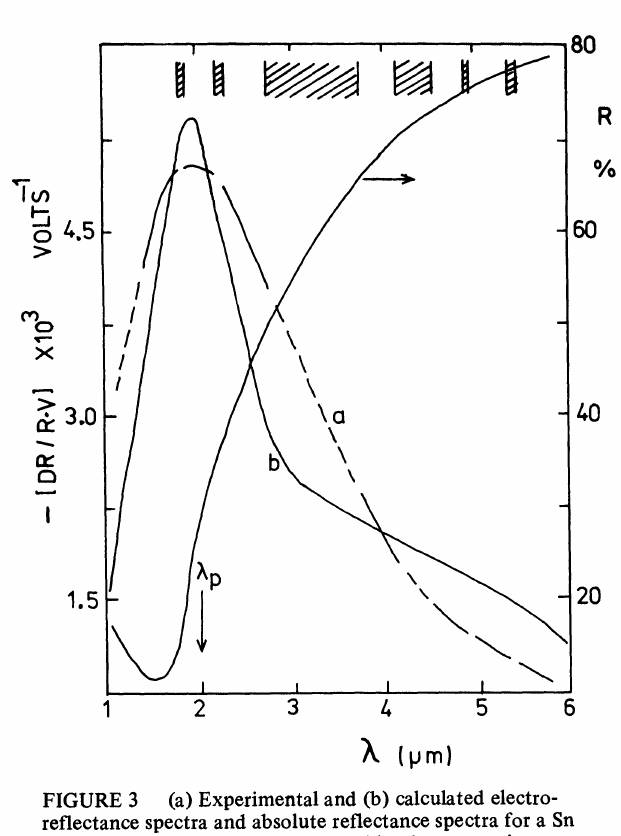
(a) Experimental and (b) calculated electro- reflectance spectra and absolute reflectance spectra for a Sn doped In On film of 45 nm prepared by d.c. sputtering. (Electrolytic capacitance was 16btFm-2